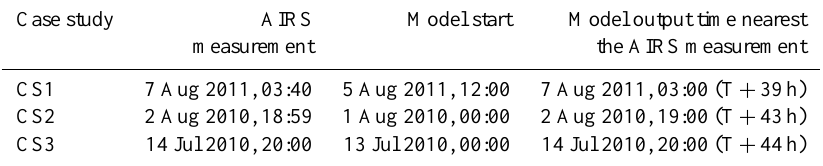
Table 1. Dates and times of the three mountain wave case studies for the AIRS measurements, the start of the mesoscale and climate model simulations, and the model output time nearest the AIRS measurements (in UTC). Case